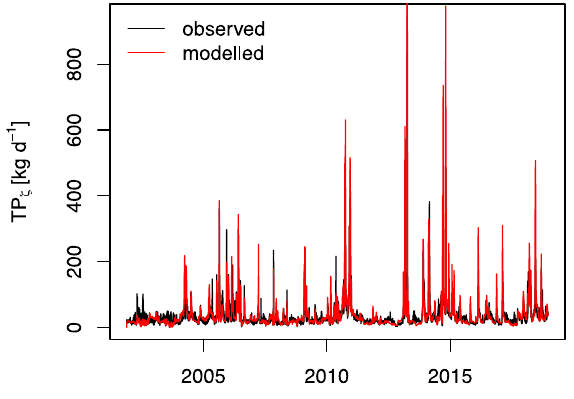
Figure 6. Observed and modelled TP fluxes at site ζ .